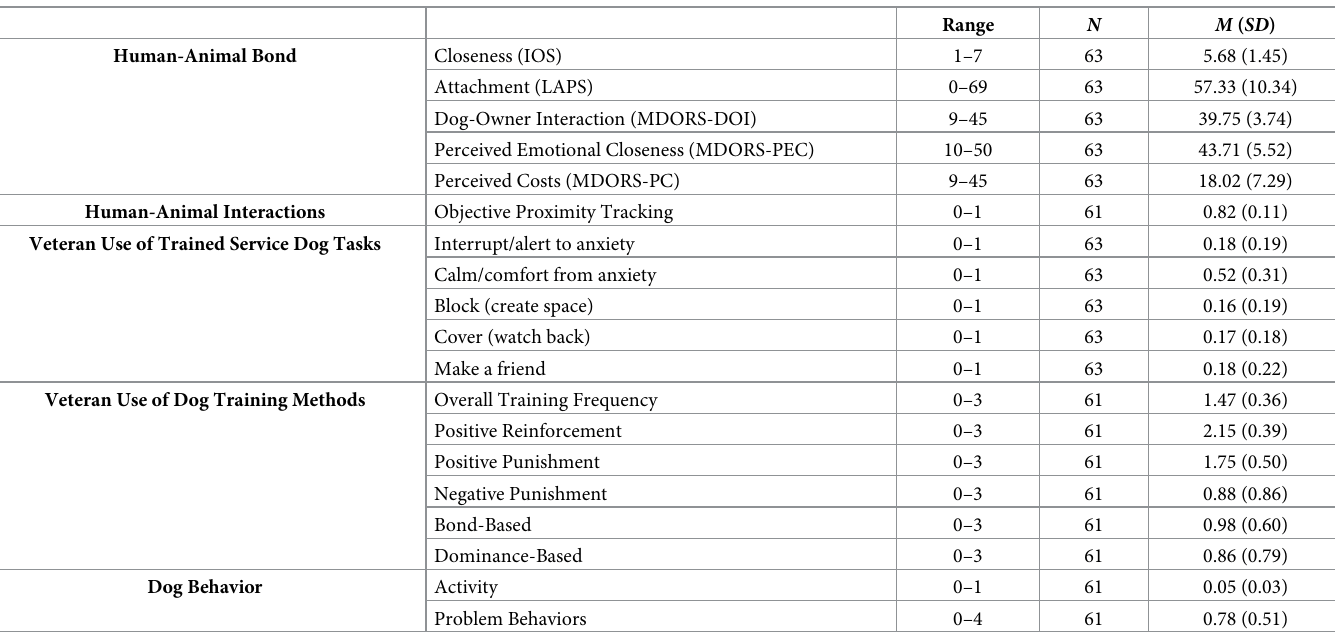
Table 4. Veteran-service dog dyadic